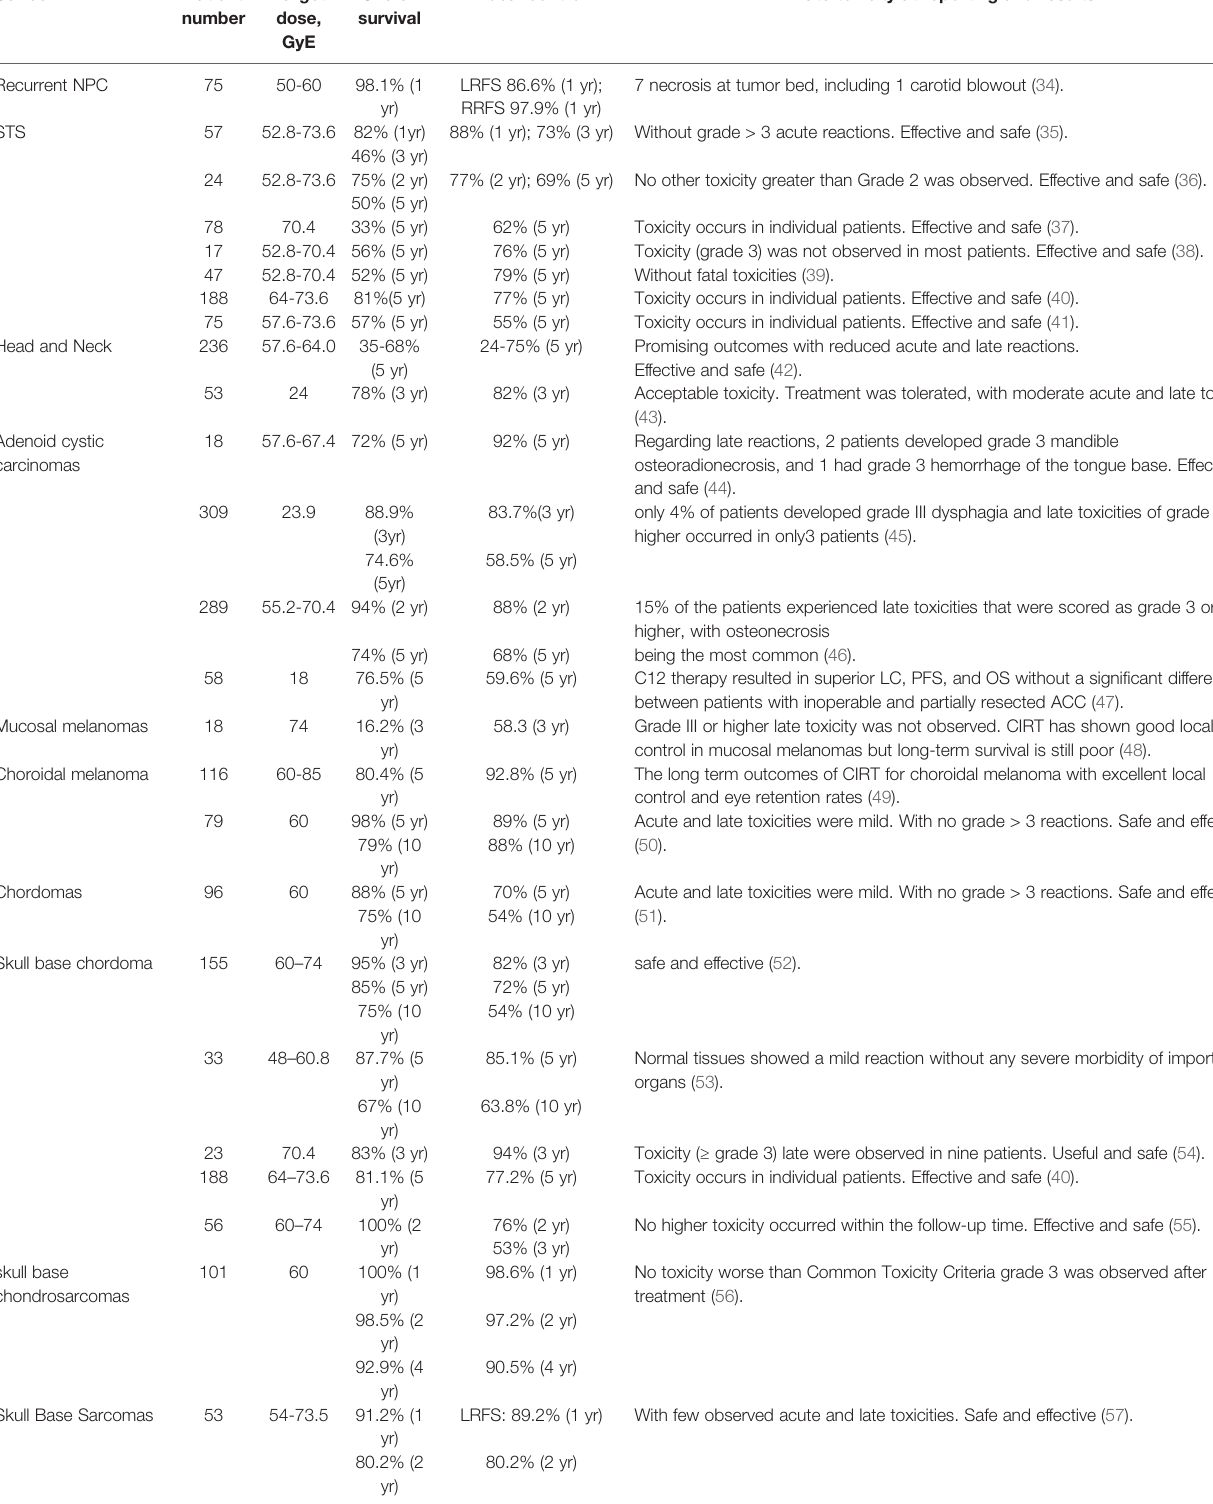
TABLE 4 | A summary of selected clinical outcomes for treatment of kinds of cancers with C-ion